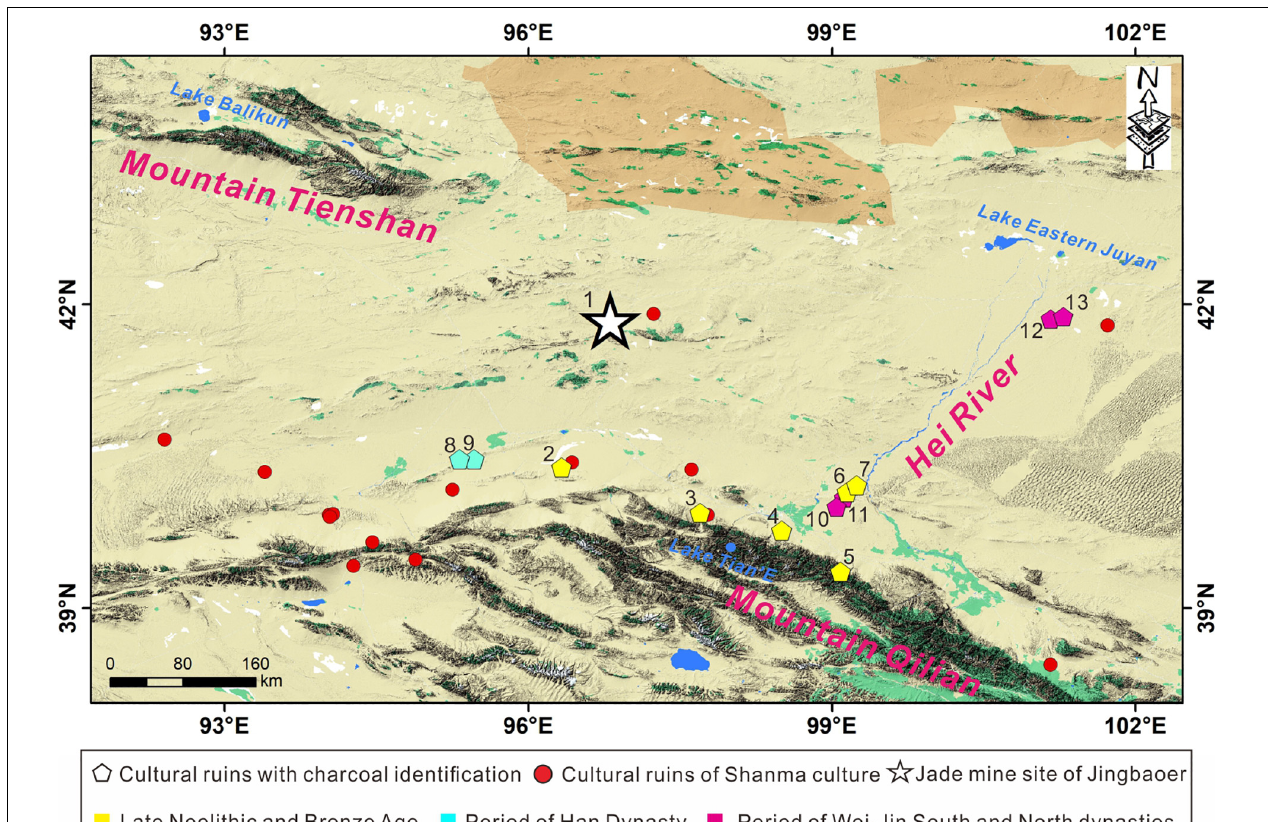
FIGURE 1 | Distribution of archeological sites yielding charcoal analyses and Shanma culture localities in the western Hexi Corridor. (1) JBR jade mine site. (2) Yingwushu. (3) Huoshaogou. (4) Zhaojiashuimo. (5) Xihetan. (6) Ganggangwa. (7) Huoshiliang. (8) Lucaogou 1. (9) Lucaogou 2. (10) Huishui. (11) Xisanjiao. (12) K749. (13)